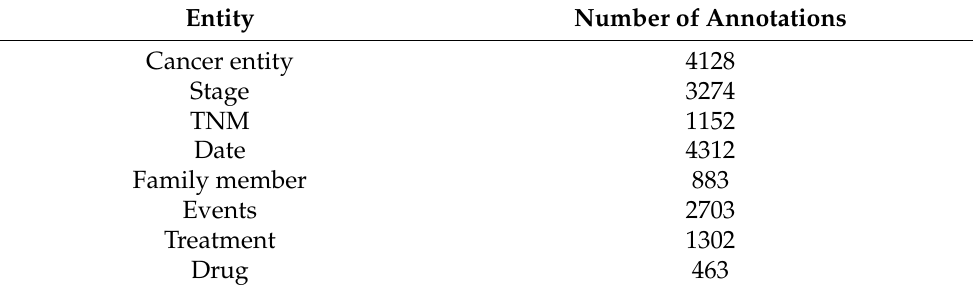
Table 1. Number of annotations for each entity in the